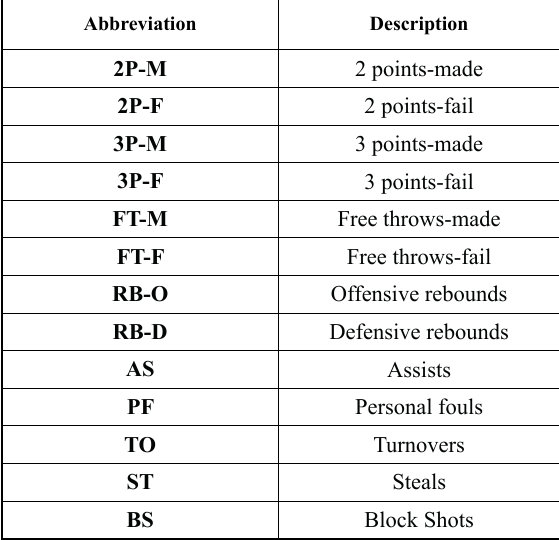
Table 1. Abbreviations and descriptions of each situational